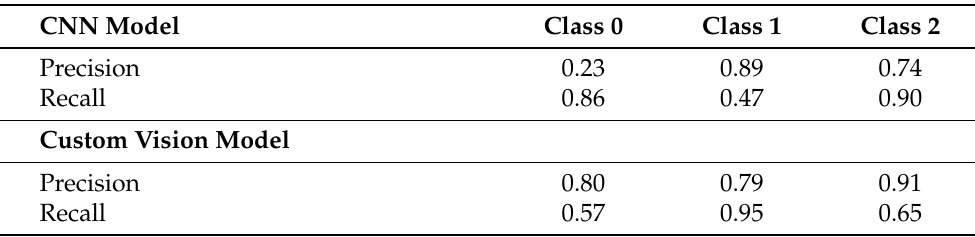
Table 27. Precisions and recalls for best CNN Model and Custom Vision model corrected with original training vector on the test set.